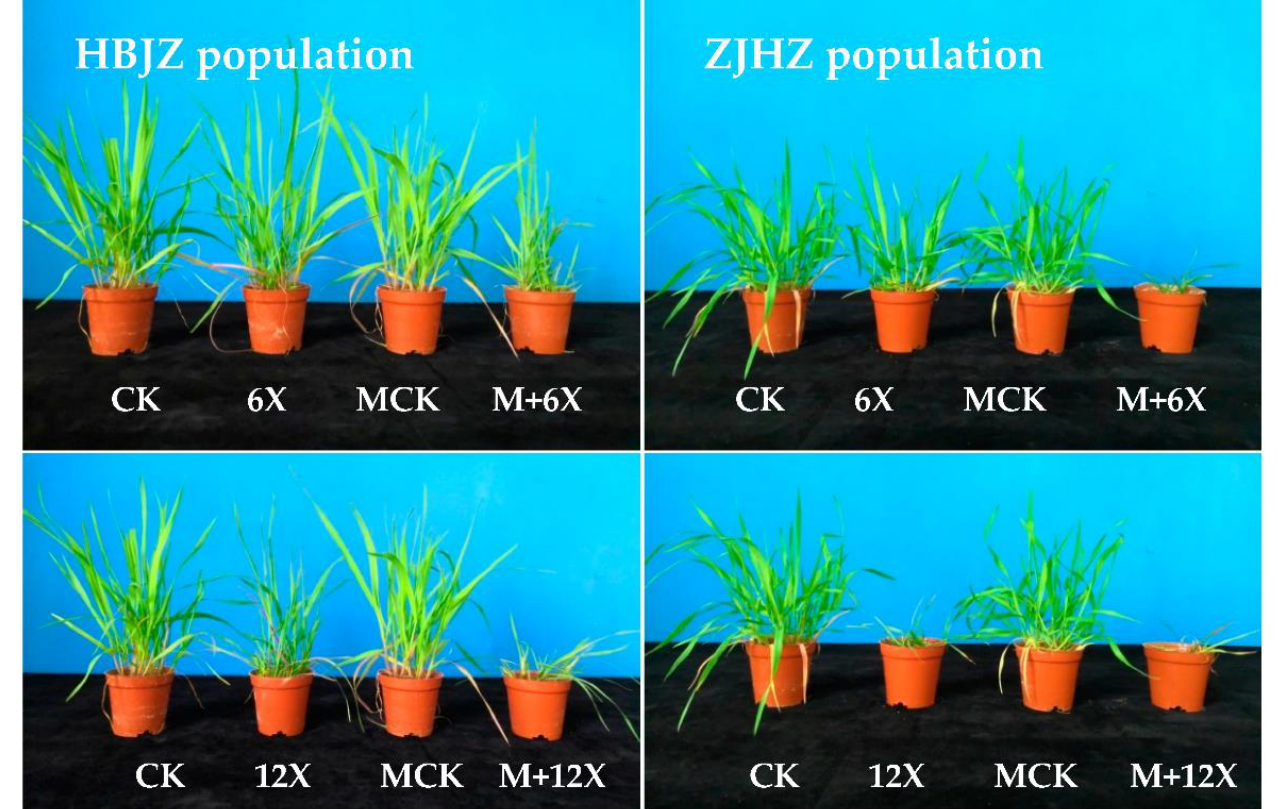
Figure 1. Photographs of R. kamoji HBJZ ( left ) and ZJHZ ( right ) populations 21 days after treatment. The first row, showing the untreated control (CK), the metsulfuron-methyl treatment (X represents the recommended field dose of metsulfuron-methyl 7.5 g ai ha − 1 , and 6X, 45 g ai ha − 1 ), the malathion treatment control (MCK), the malathion plus metsulfuron-methyl treatment (M + 6X); and the second row, showing the untreated control (CK), the metsulfuron-methyl treatment (12X, 90 g ai ha − 1 ), the malathion treatment control (MCK), the malathion plus metsulfuron-methyl treatment (M + 12X).